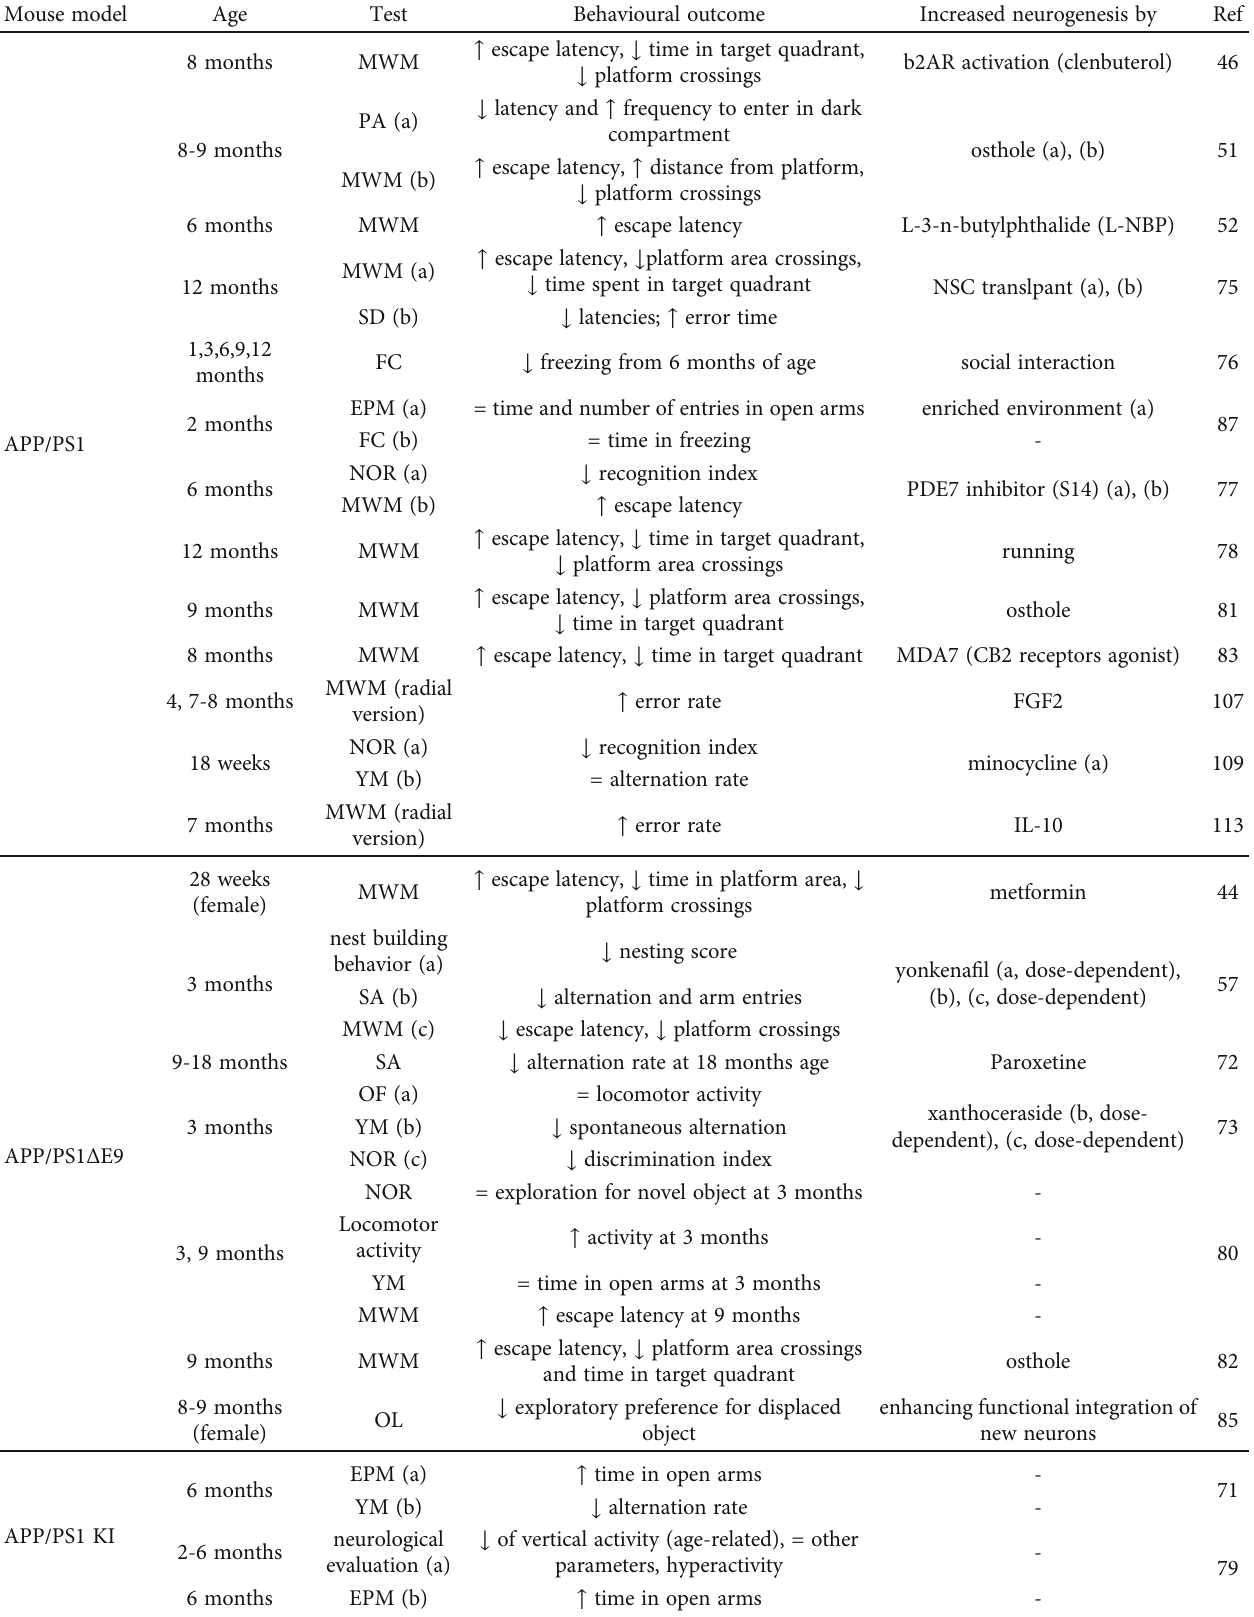
Table 2: Studies investigating memory in relation to AHN in AD mouse